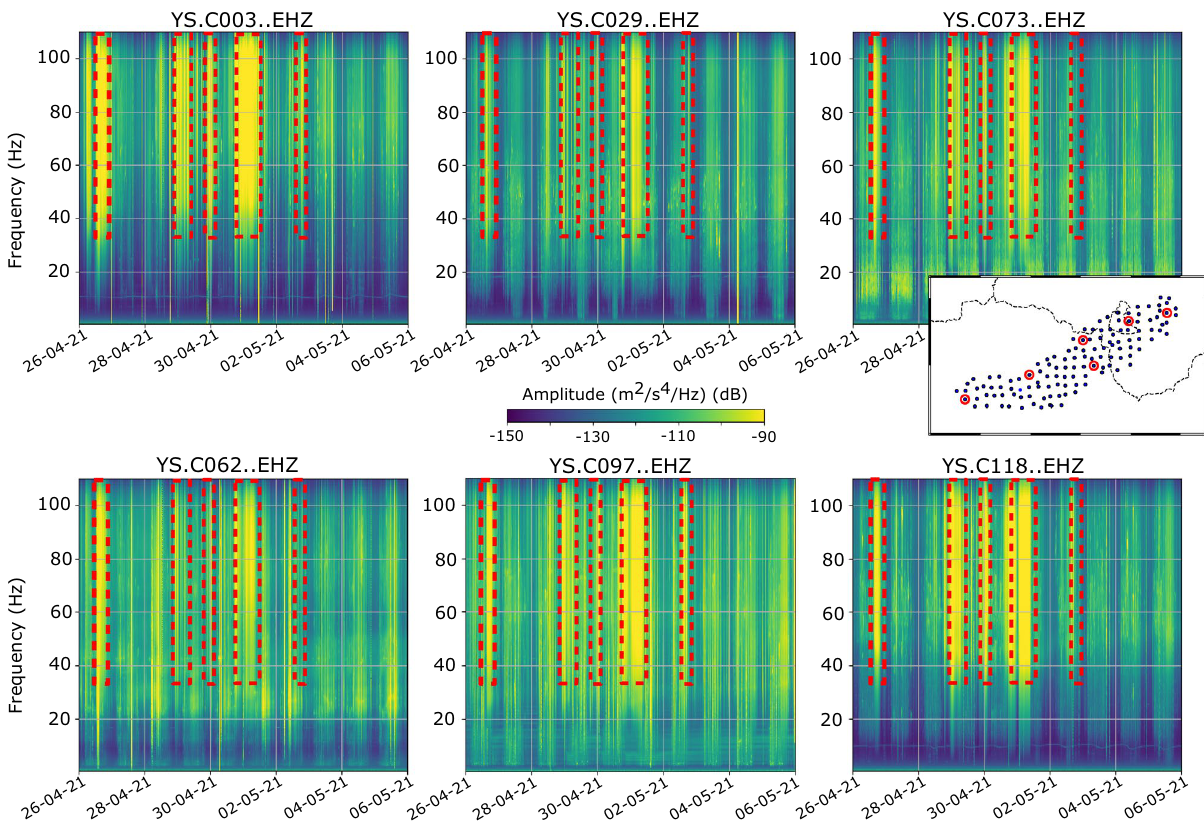
Figure 2. Spectrograms corresponding to the 26/4–6/5/2021 period for representative stations distributed along the network. Yellowish colors correspond to large energy levels. The time intervals with higher energy at frequencies above 40 Hz (red dashed boxes) can be identified at each